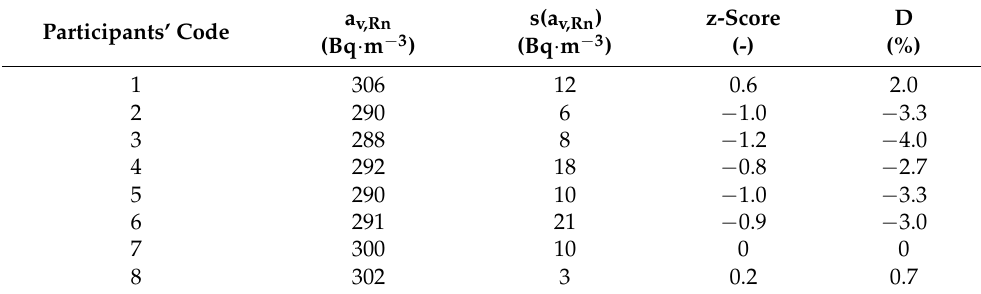
Table 4. Results for a level of radon activity concentration of 300 Bq·m −3.